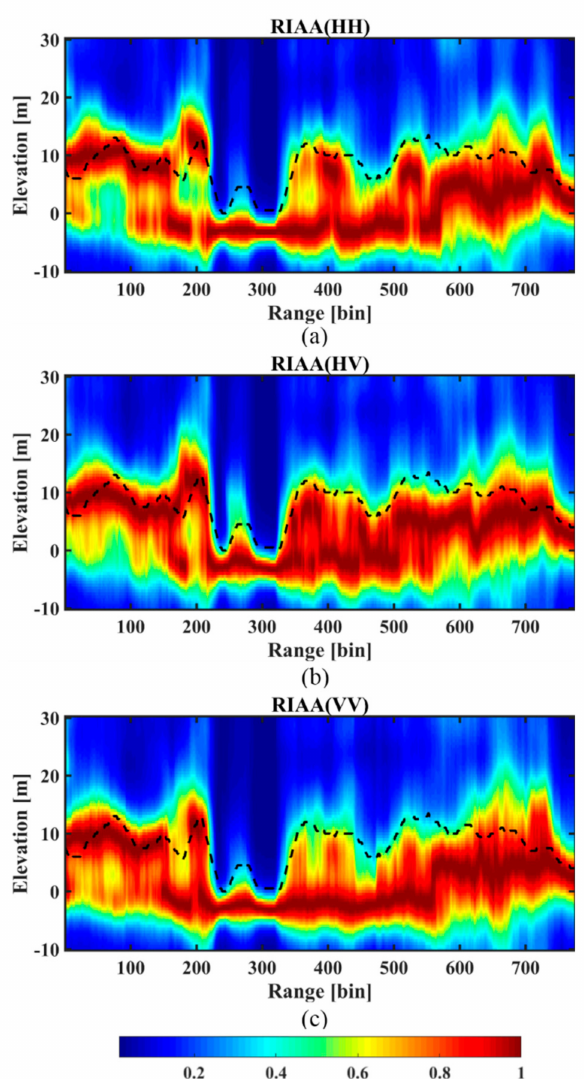
Figure 7. The tomograms of the selected profile estimated by the RIAA method for the three different polarimetric channels: ( a ) HH; ( b ) HV; ( c ) VV. The black dotted lines represent CHM.